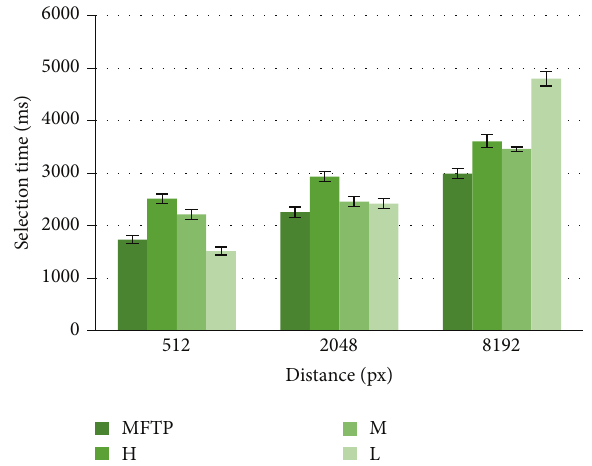
Figure 9: Mean selection time for each technique and target dis- tance. Overall LMH is the most balanced technique across the dis- tances (error bars: 95% confidence